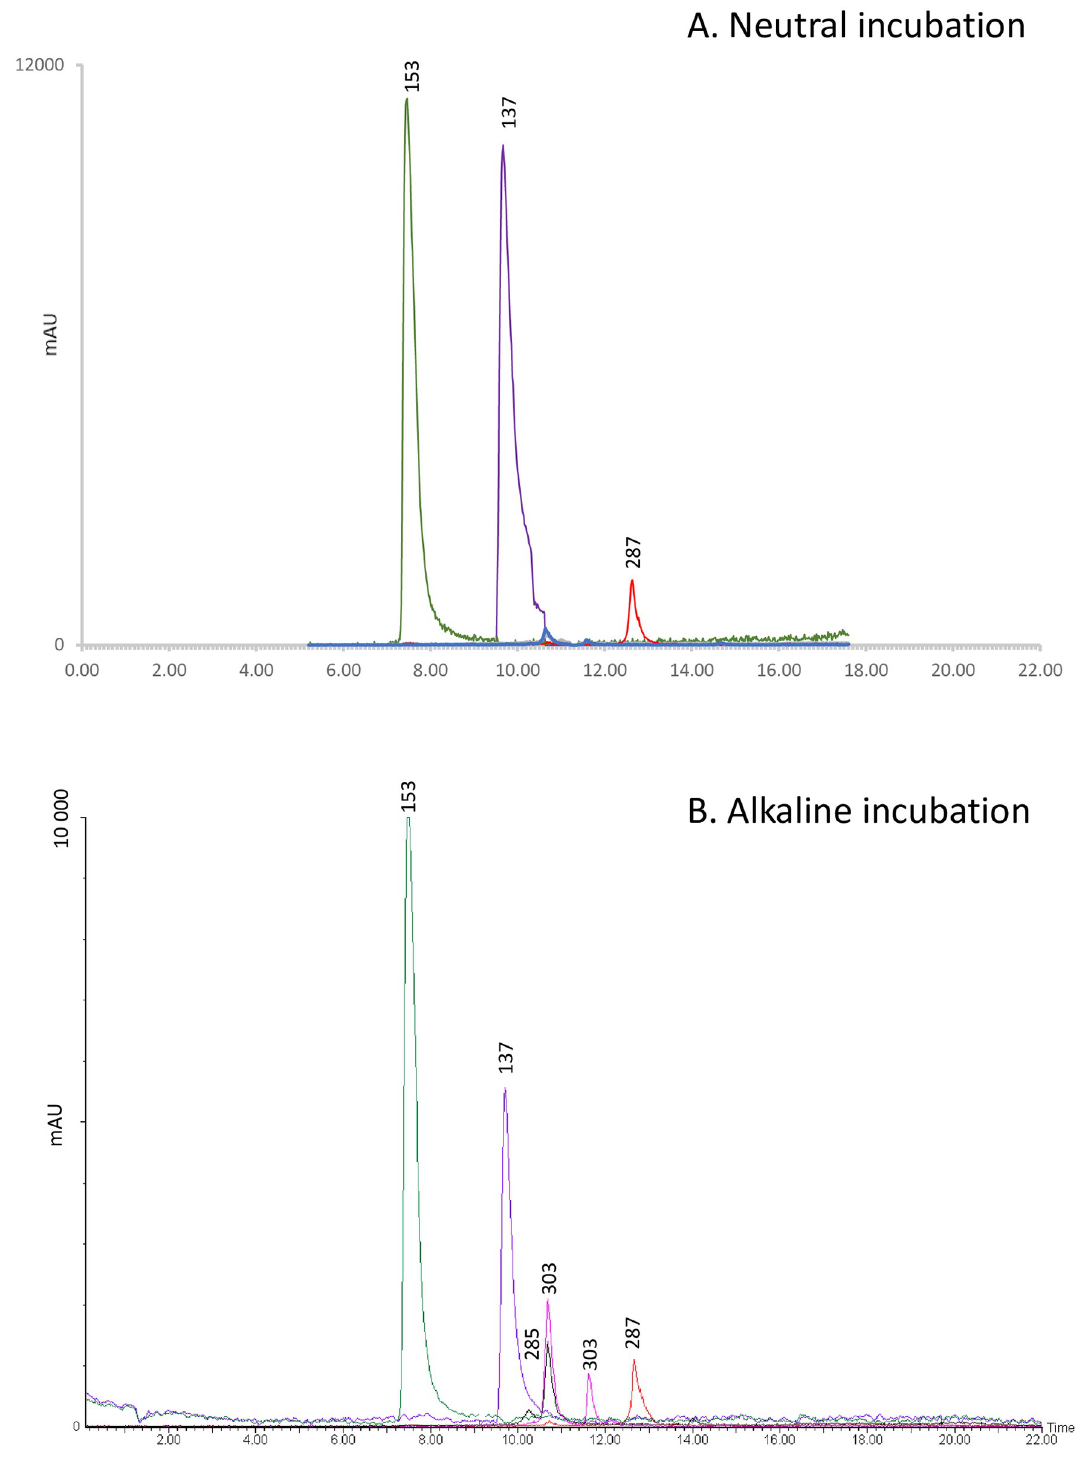
Fig 2. Acetophenone incubation chromatograms. HPLC-DAD chromatograms of the piceol/pungenol mixture incubated at A. neutral and B. alkaline pH. Numbers represent m/z of identified peaks: 137 = piceol, 153 = pungenol, 285, 287 and 303 = putative